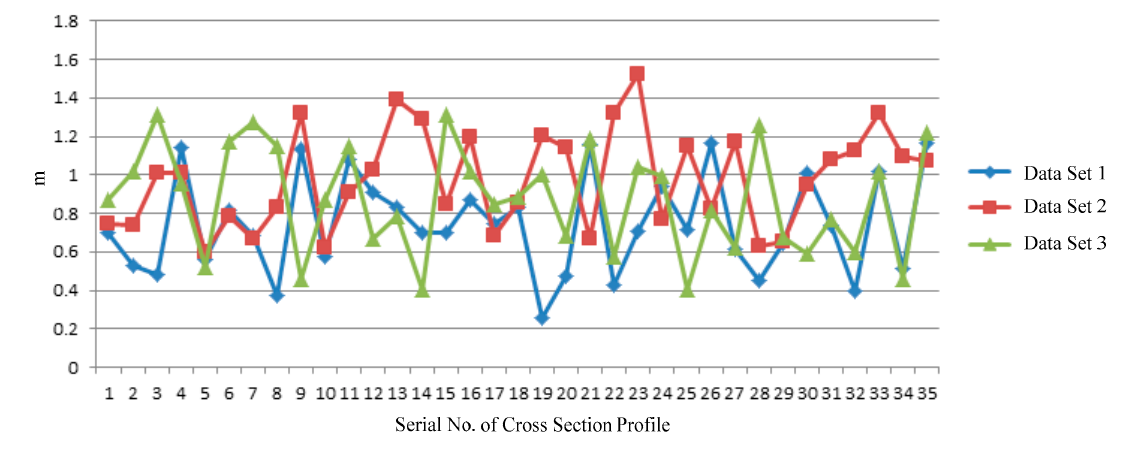
Figure 17. Clearance inspection result of tunnel wall.